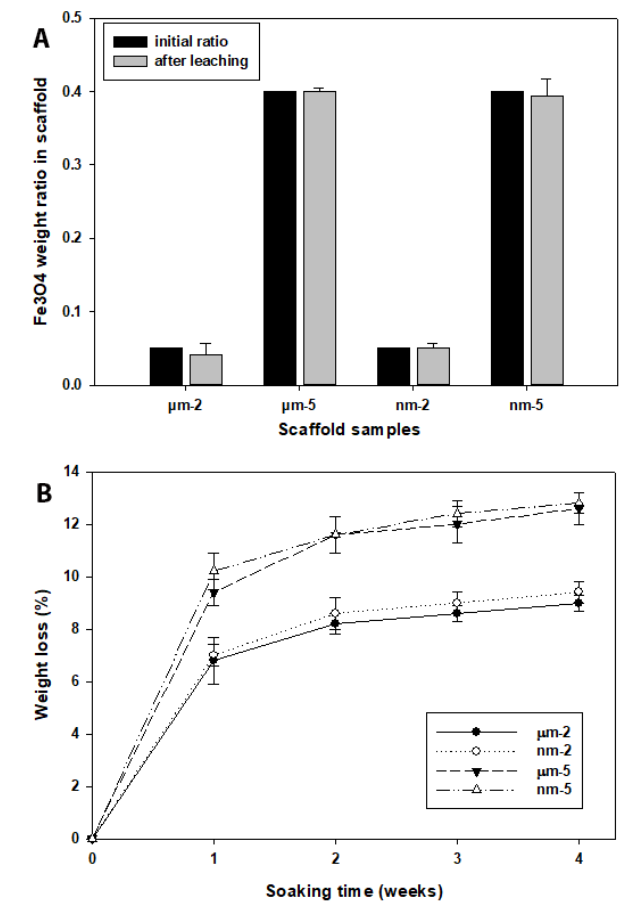
Figure 4. ( A ) Magnetic particle weight test in scaffolds of different groups. The final particle